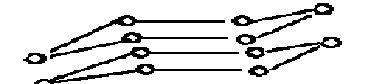
Figure 3. Transformation of graphene into H6 diamond with electric field polarization perpendicular to the graphene plane [25]. H6 diamond.: Stack of chair shape carbon hexagonal rings (sp3 bonded to four others). Raman frequency at~1325 cm − 1 according to McNamara et al. [116] and Spear et al. [189] and Phelps et al. [190].